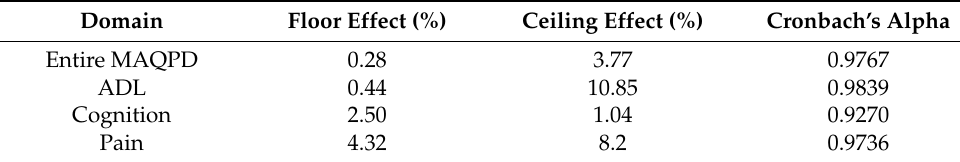
Table 4. Analysis of the accuracy of the MAQPD